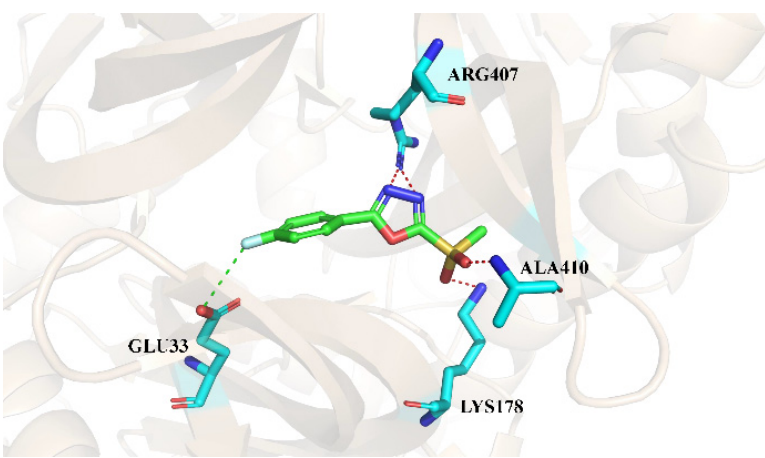
Figure 2. The binding mode of JHXJZ.